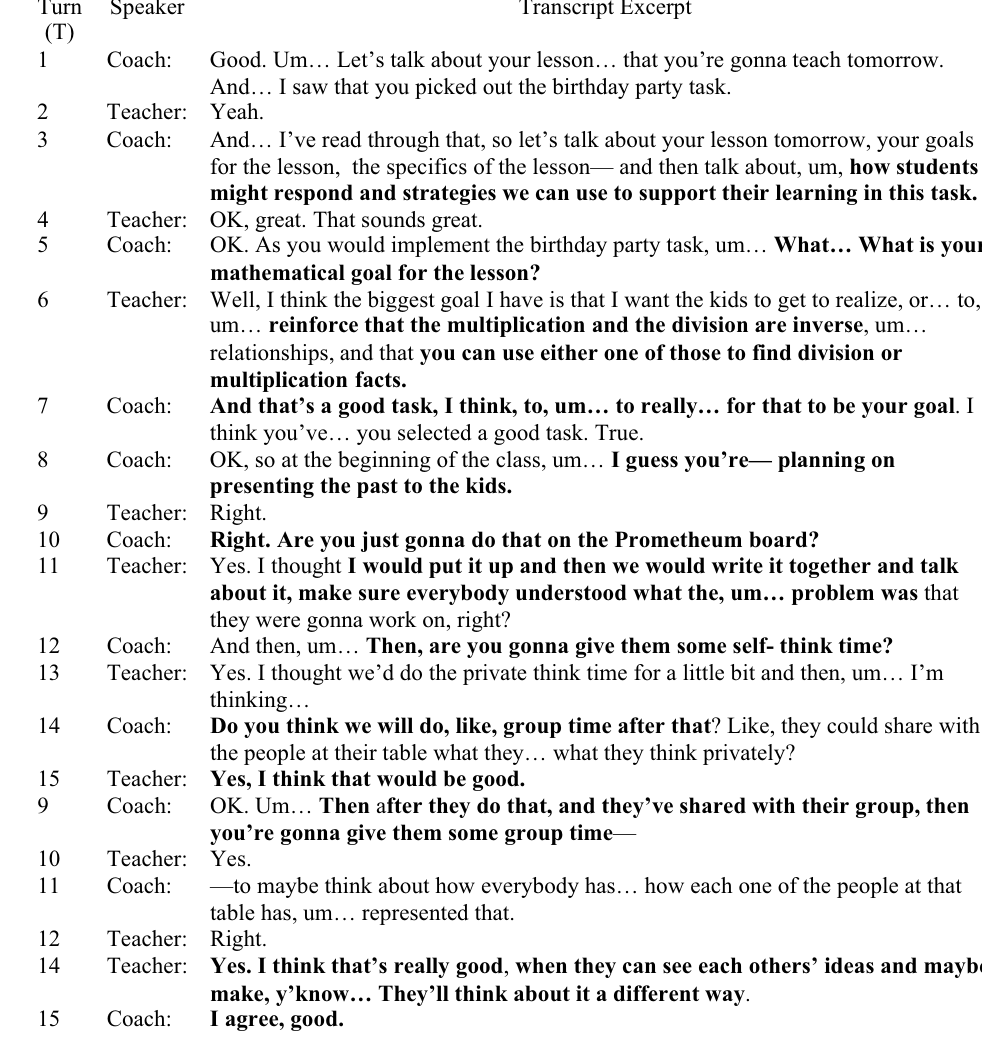
Fig. 6 Excerpt illustrating low-growth theme